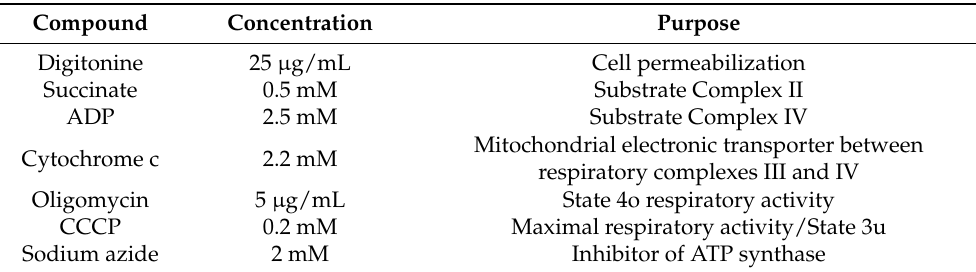
Table 1. Compounds used to analyze the ETC in mitochondria-C6/36 mock and DENV2- infected cells.